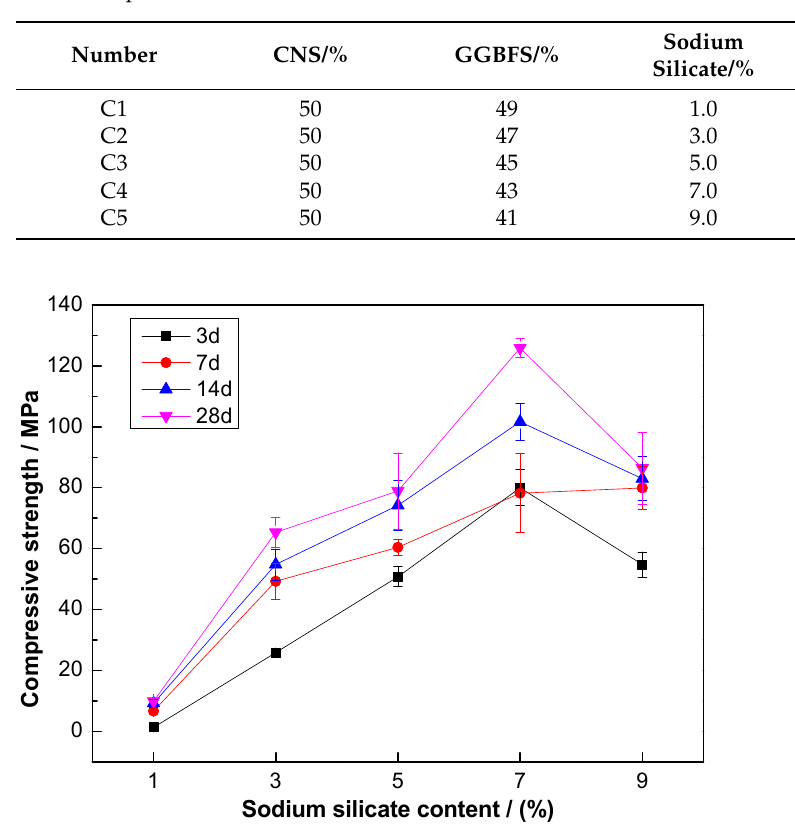
Figure 9. Compressive strength of CNS samples with different sodium silicate contents.